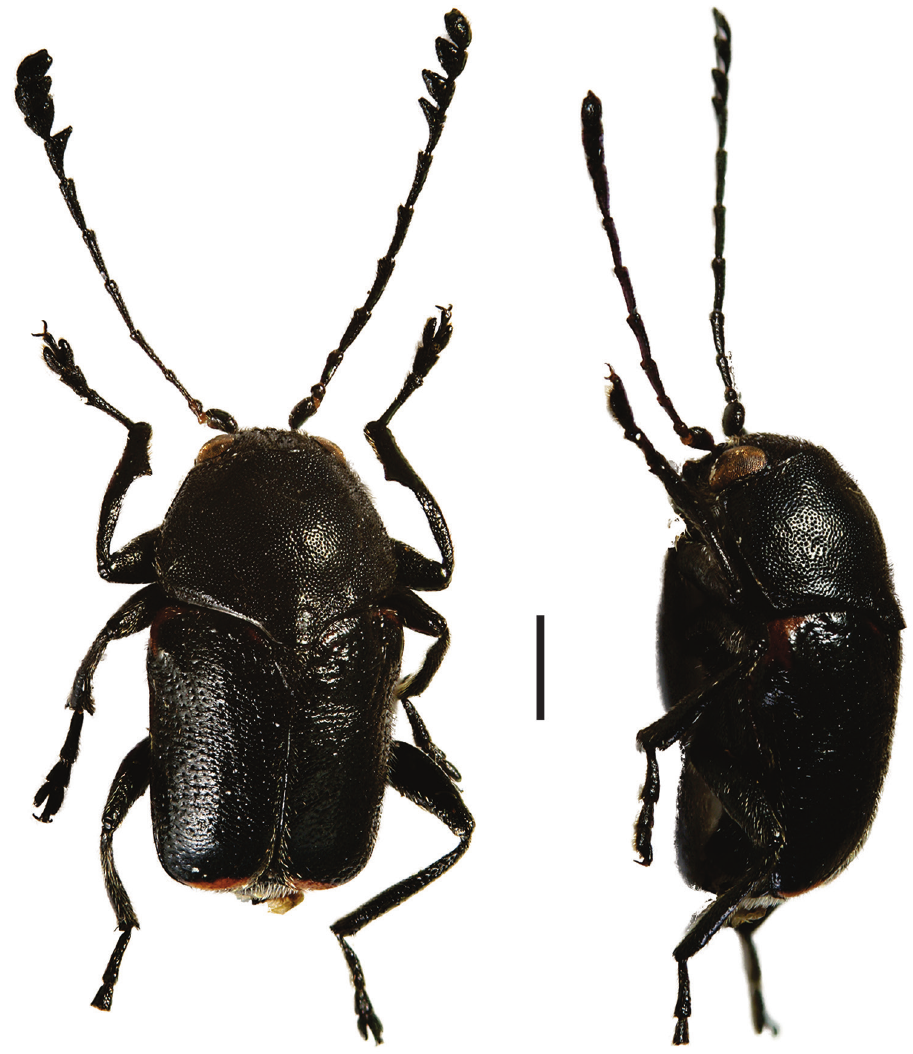
Figure 26. Mylassa pectinicornis (Suffrian) (4) , left: habitus (dorsal view), right: habitus (lateral view). Remarks. This genus was considered a synonym of Cryptocephalus by several authors, however several studies support its validity and it is hypothesized to be included in Pachy- brachina (Baly 1877b; Jakobson 1924; Monrós 1949a, Schöller 2008; Jerez and Briones 2010) or in its own subtribe (Reid 1990; Chamorro and Konstantinov, unpublished data). Argentinian species